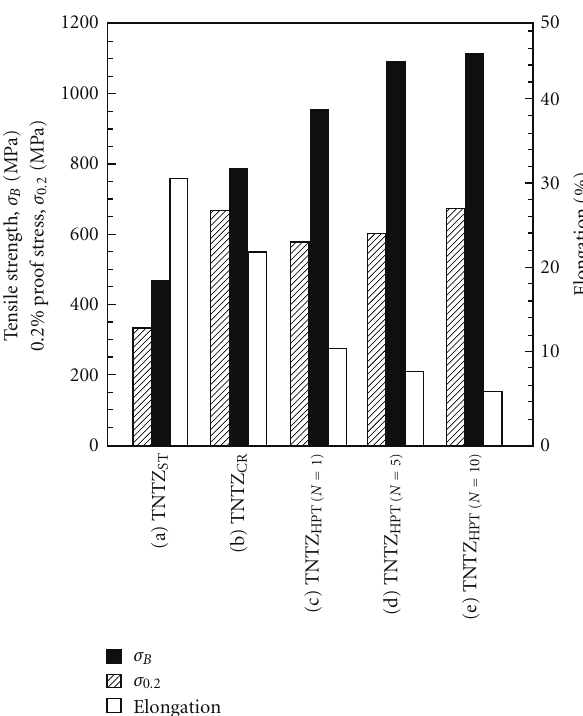
Figure 3: Tensile properties of TNTZ subjected to (a) solution treatment (TNTZ ST ), (b) severe cold rolling (TNTZ CR ), (c) HPT at a rotation number, N , of 1 (TNTZ HPT( N = 1) )), (d) HPT at a rotation number, N , of 5 (TNTZ HPT( N = 5) ), and (e) HPT at a rotation number, N , of 10 (TNTZ HPT( N = 10) ).